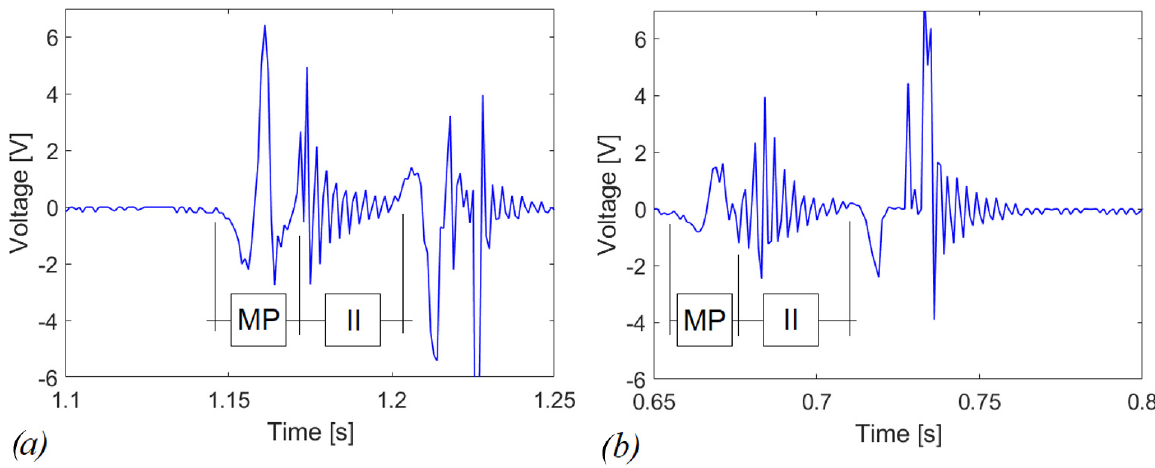
Figure 12. Close-up on voltage responses in case of load resistance, R = 100 k Ω ( a ) repulsive case ( b ) attractive case. MP—magnetic plucking, II—indirect impact.